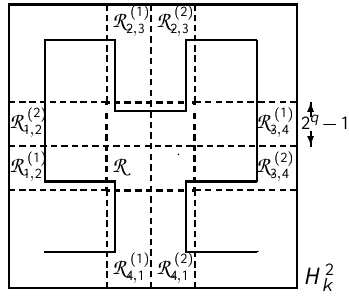
1 (cid:13) i i mod 4 (cid:21) 1 (cid:12) (cid:14)